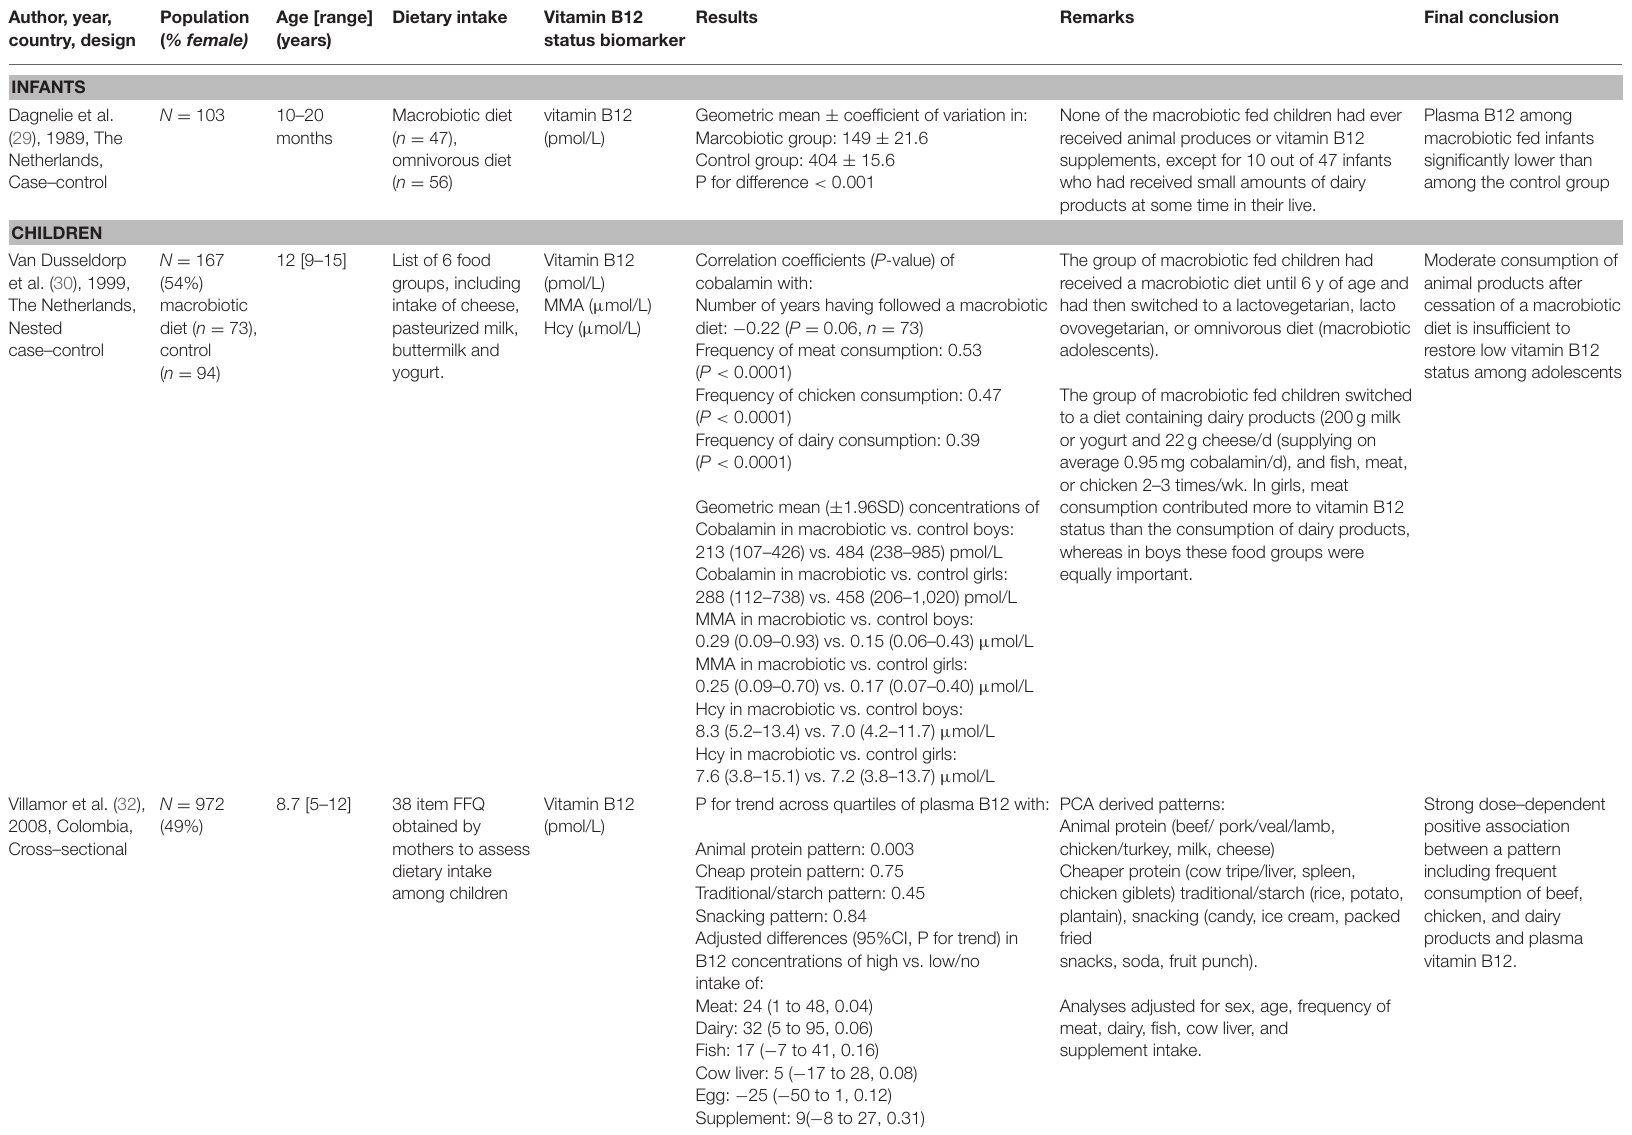
TABLE 4 | Main characteristics and results of observational studies addressing the relation between dietary intake and vitamin B12 status biomarkers among different age